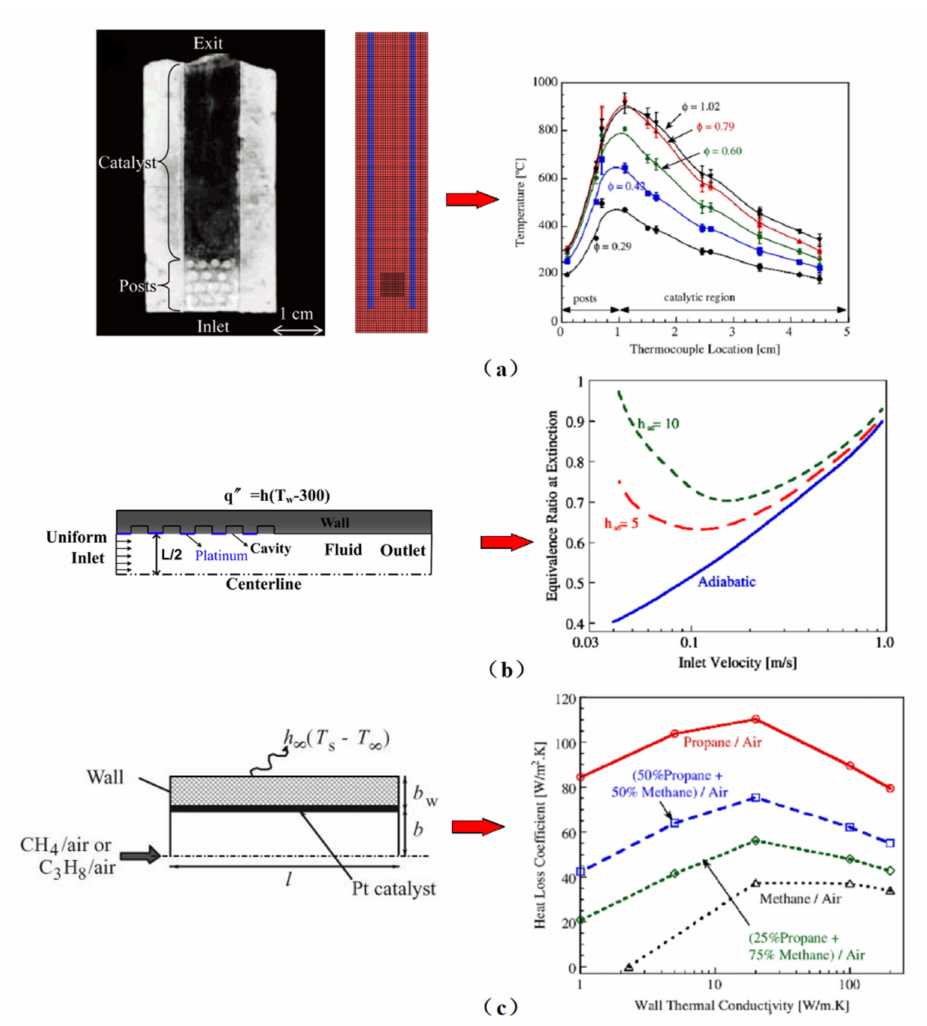
Figure 32. Ceramic micro burner temperature for Pt-catalyzed hydrogen combustion [163]. ( a ) Tem- perature field, ( b ) Equivalence ratio at extinction, ( c ) Heat loss